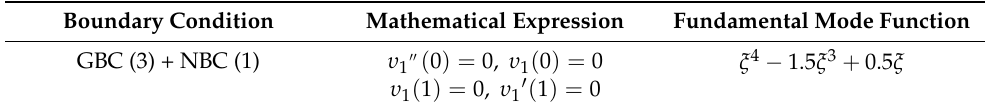
Table 4. Simple-fixed fundamental mode function ( υ 1 ).